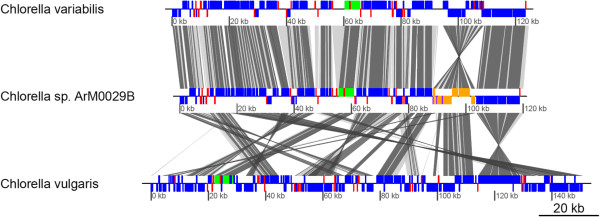
Comparison of the cp genomes of C. variabilis, Chlorellasp. ArM0029B, and C. vulgaris. Thick bars represent protein-coding genes (blue), rRNA genes (green), and tRNA genes (red). Genes in the inverted region were highlighted in orange (protein-coding genes) and purple (tRNA genes) boxes in ArM0029B. LCBs and conserved genes are connected by light and dark gray rhomboids, respectively.